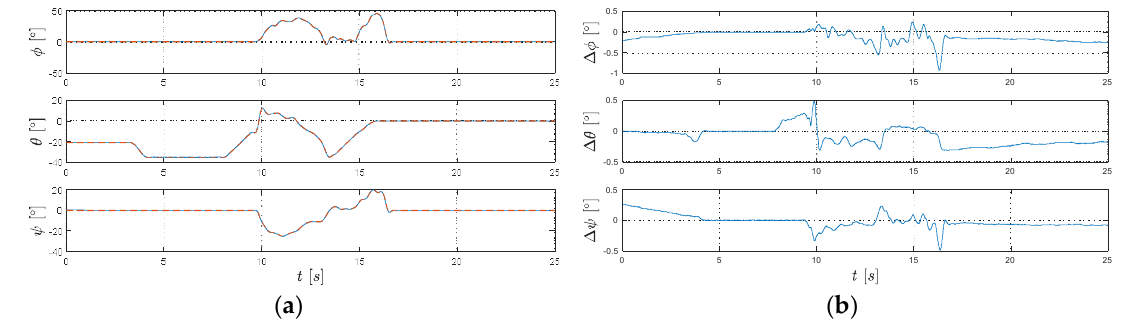
Figure 1. Result for simulated reference data: ( a ) Comparison between simulated reference (red) and estimated Euler angles (blue); ( b ) The estimation errors in the Euler angles, all of the errors are smaller than 1 degree.